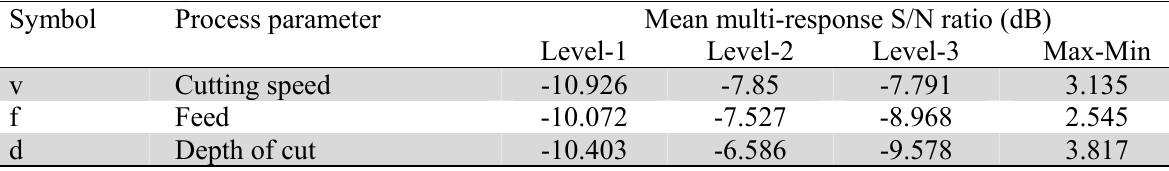
Mean multi-response S/N table for case-2 (w 1 = 3, w2 = 7)